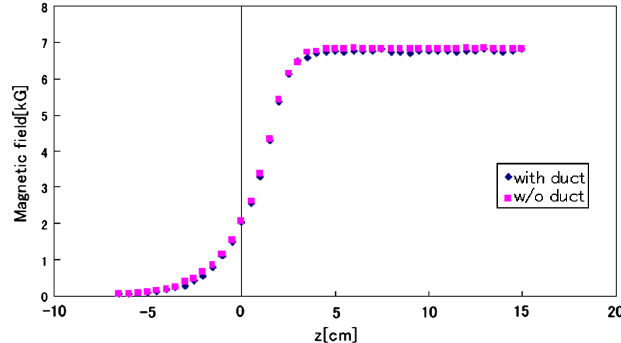
FIG. 25. Peak fields of the septum magnet along the beam axis.